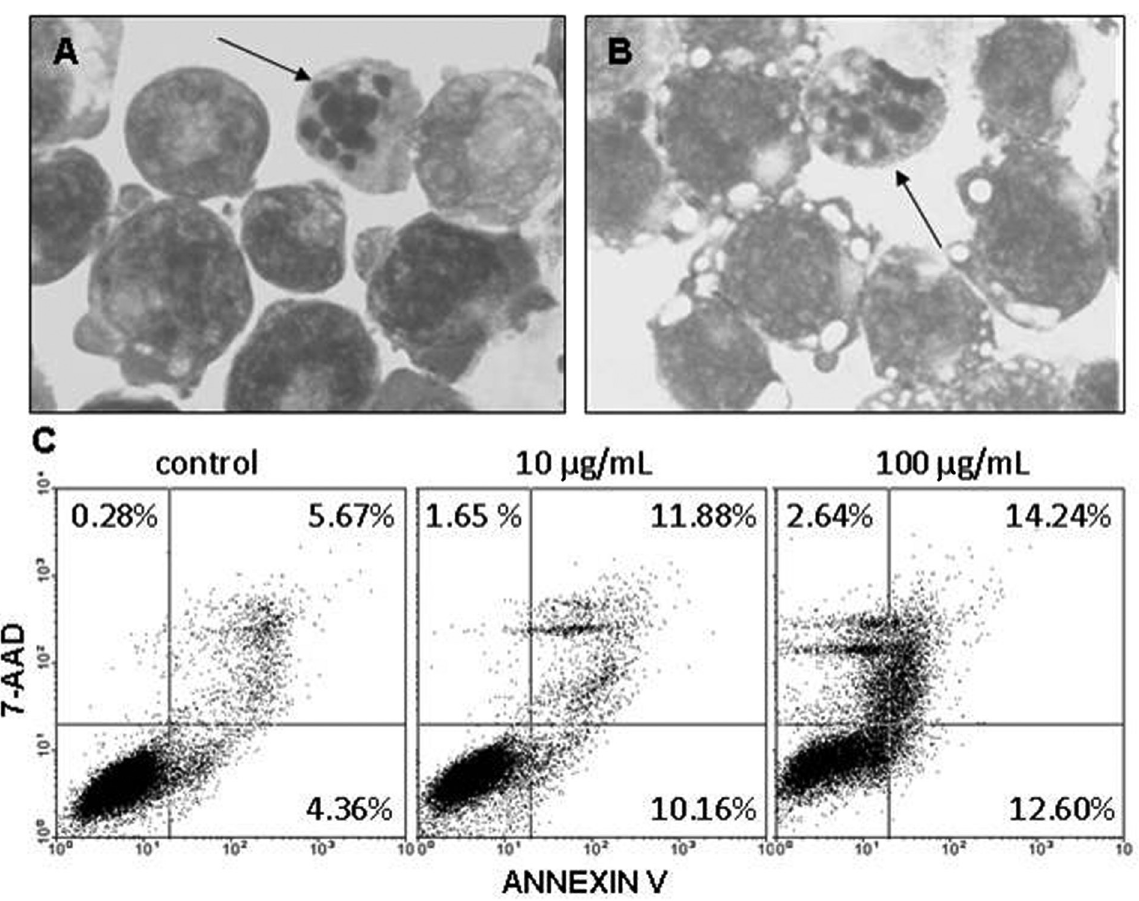
FIGURE 5 - Alkaloid-rich fraction of H. lancifolius does not induce apoptosis in leukemic cells. K-562 and Daudi cells plated in RPMI 1640 at 37 °C for 24 h were treated with increasing doses (0.1-100 µg/mL) of ARF for 48 h. The morphology of the cultured cells was observed by immersion oil microscopy in cytospin preparations stained with May-Grunwald-Giemsa. The photos depict K-562 (A) and Daudi (B) cells after treatment with 10 µg/mL of ARF. Rare apoptotic figures were observed (arrows). Magnification: ×1000. Panels in C show Annexin V and 7-AAD co-expression on K-562 cells after treatment with ARF, analyzed by flow